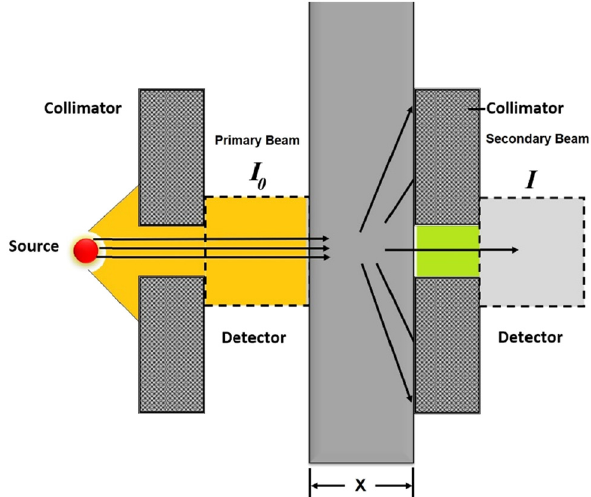
Figure 1: A typical setup for calculation of linear attenuation coe ffi cients.